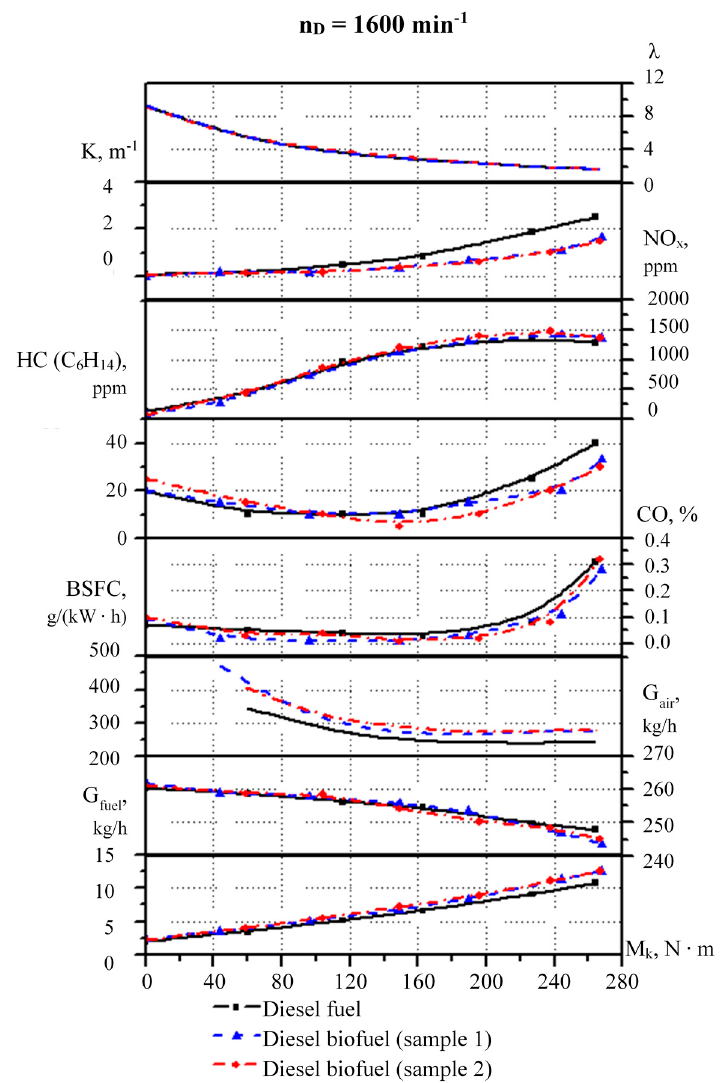
Figure 2. D-241 diesel engine load characteristics.